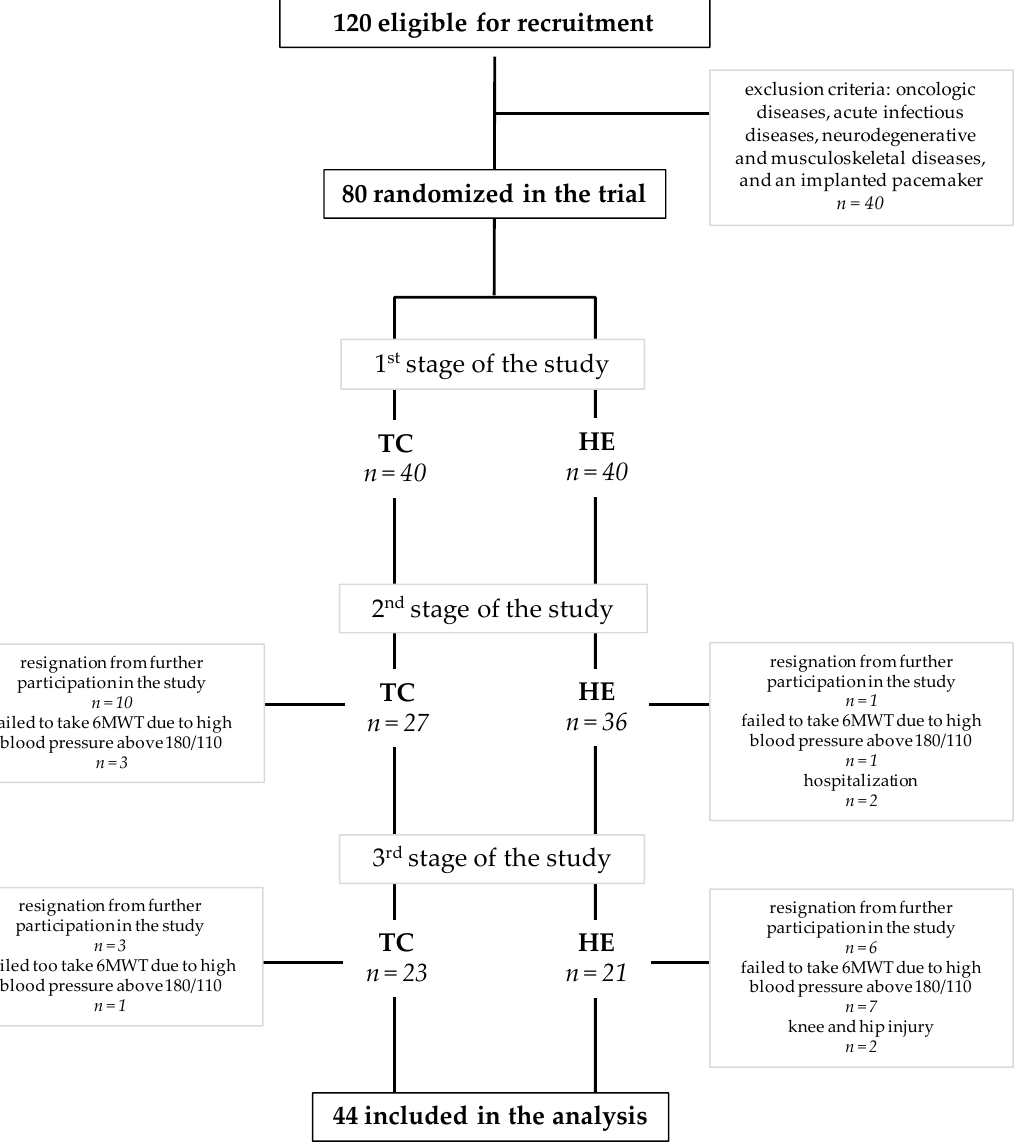
Figure 1. Flow chart of study subjects’ participation. Abbreviations: TC: Tai-Chi training, HE: health education, 6MWT: the 6-min walk